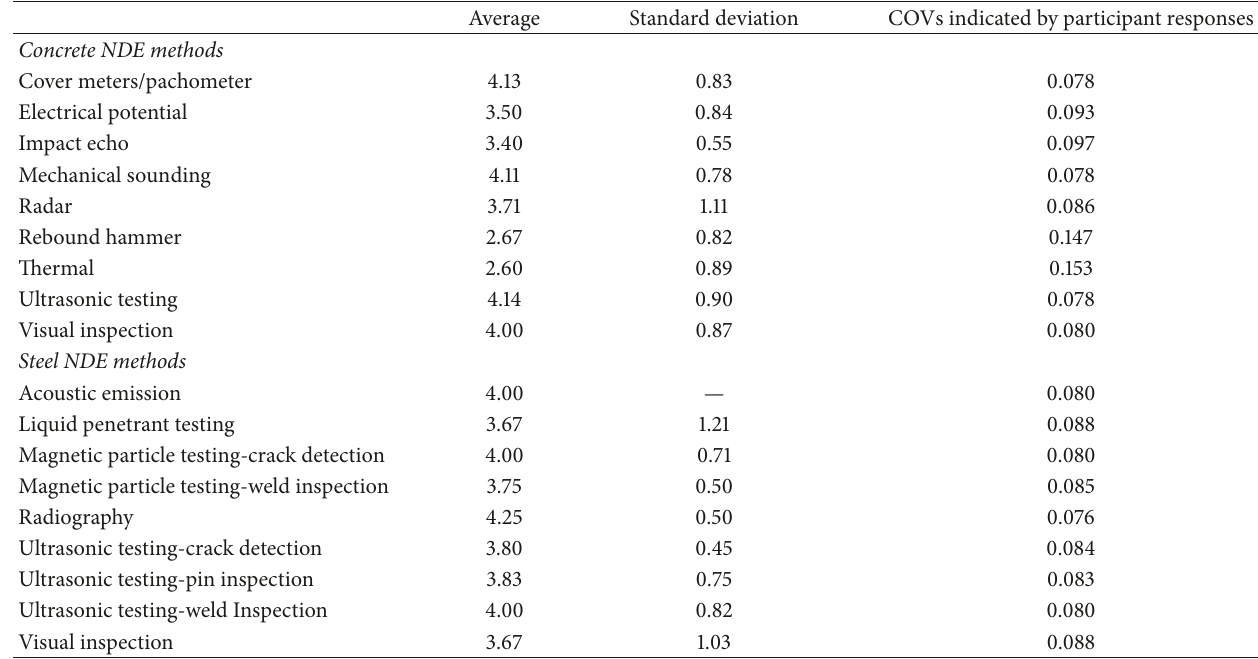
Table 6: Concrete and steel NDE methods response descriptive statistics for the reliability and the COVs indicated by participant responses.